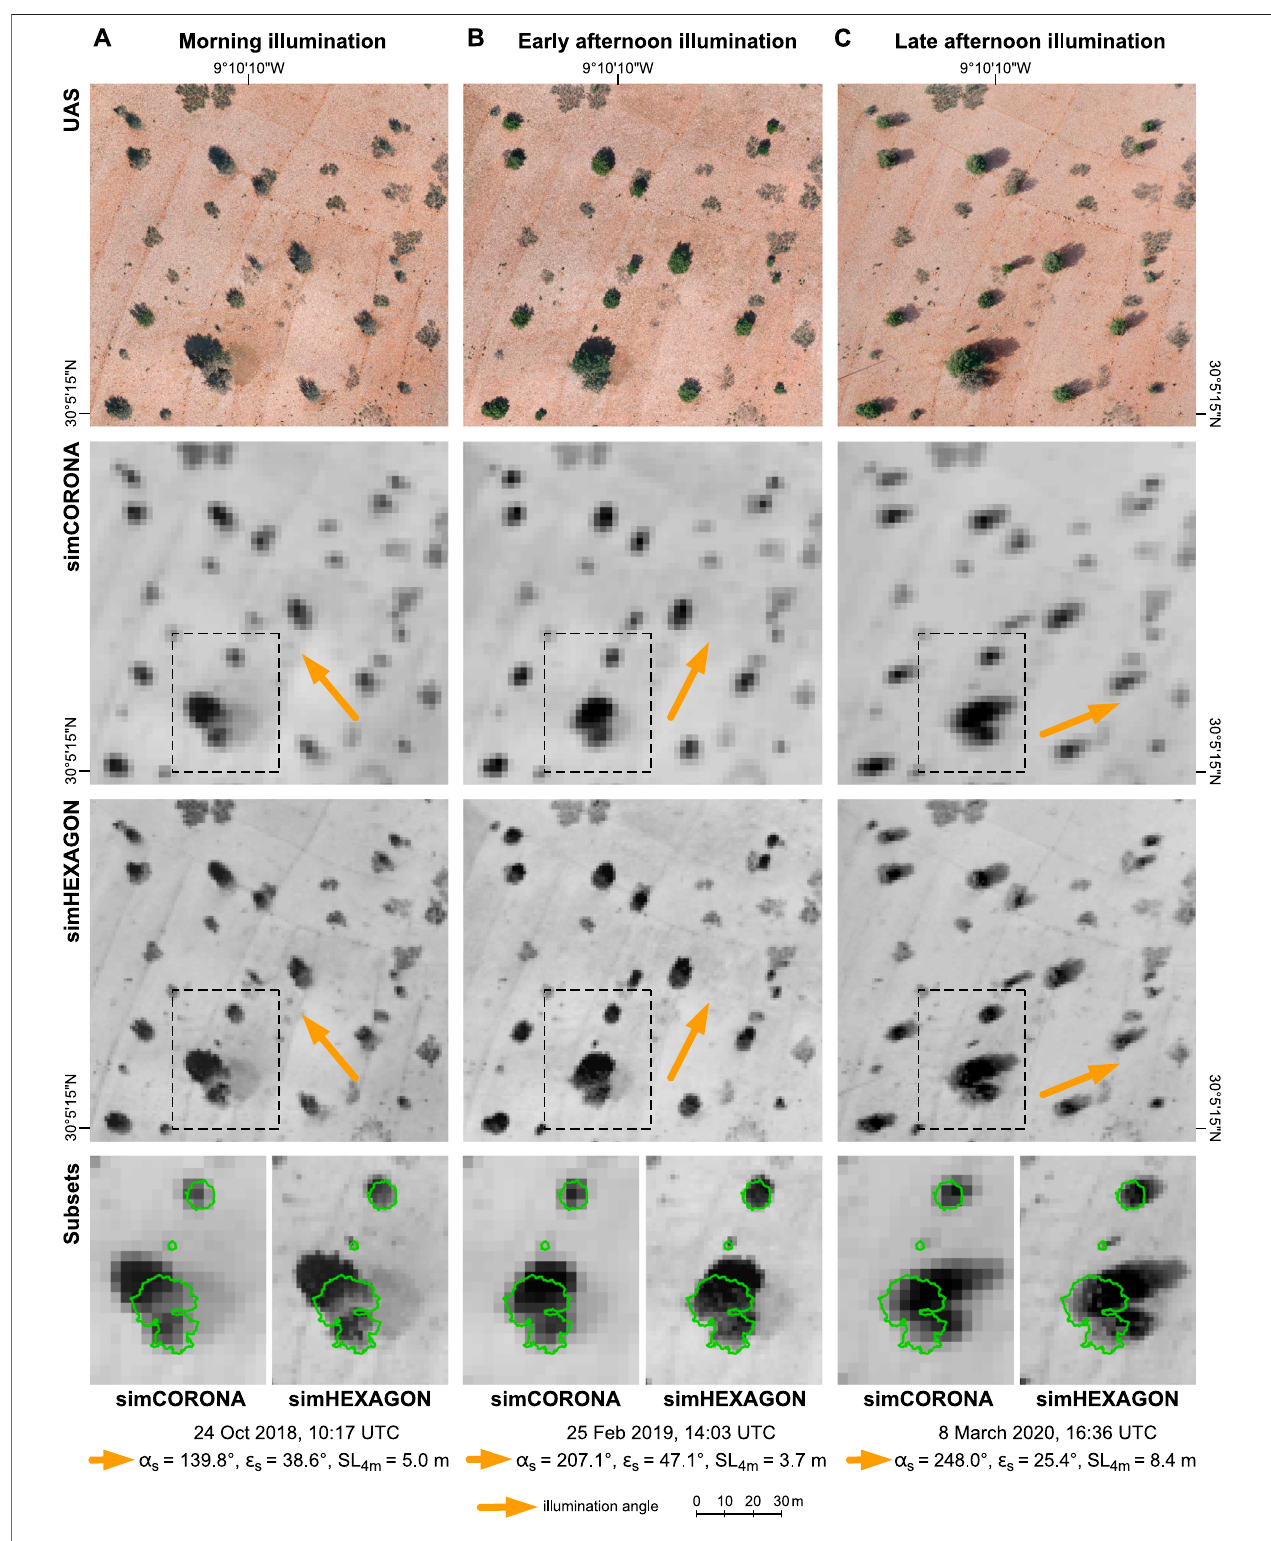
FIGURE 4 | Effect of varying sun illuminations (sun azimuth α S shown as orange arrow) on the appearance of individual trees at test site TAS1r. Morning (A) , early afternoon (B) andlateafternoonillumination (C) areshowninUASimagery(1.5 cmresolution,toprow),simulatedCORONAimagery(2.2 mresolution,secondrow)and simulatedHEXAGONimagery(1.0 mresolution,thirdrow).NotethatilluminationconditionBisverysimilarindate,timeandsunanglestotheoriginalCORONAimageof this site ( Figure 3A , top row). Subsets (bottom row) show examples for merging of crown and shadow in the appearance of small, medium and large trees (true crown areas outlined in green). For parameter abbreviations, see Figure 3 .